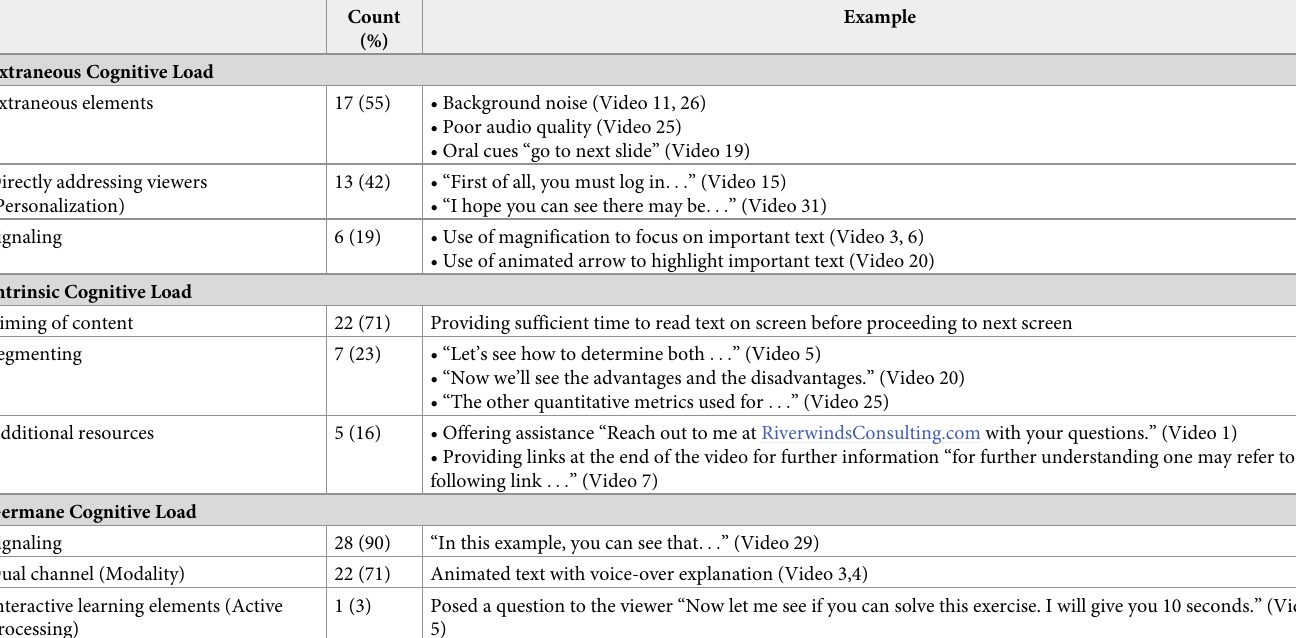
Table 3. Cognitive load factors identified in short YouTube videos on the h-index (n = 31). Count